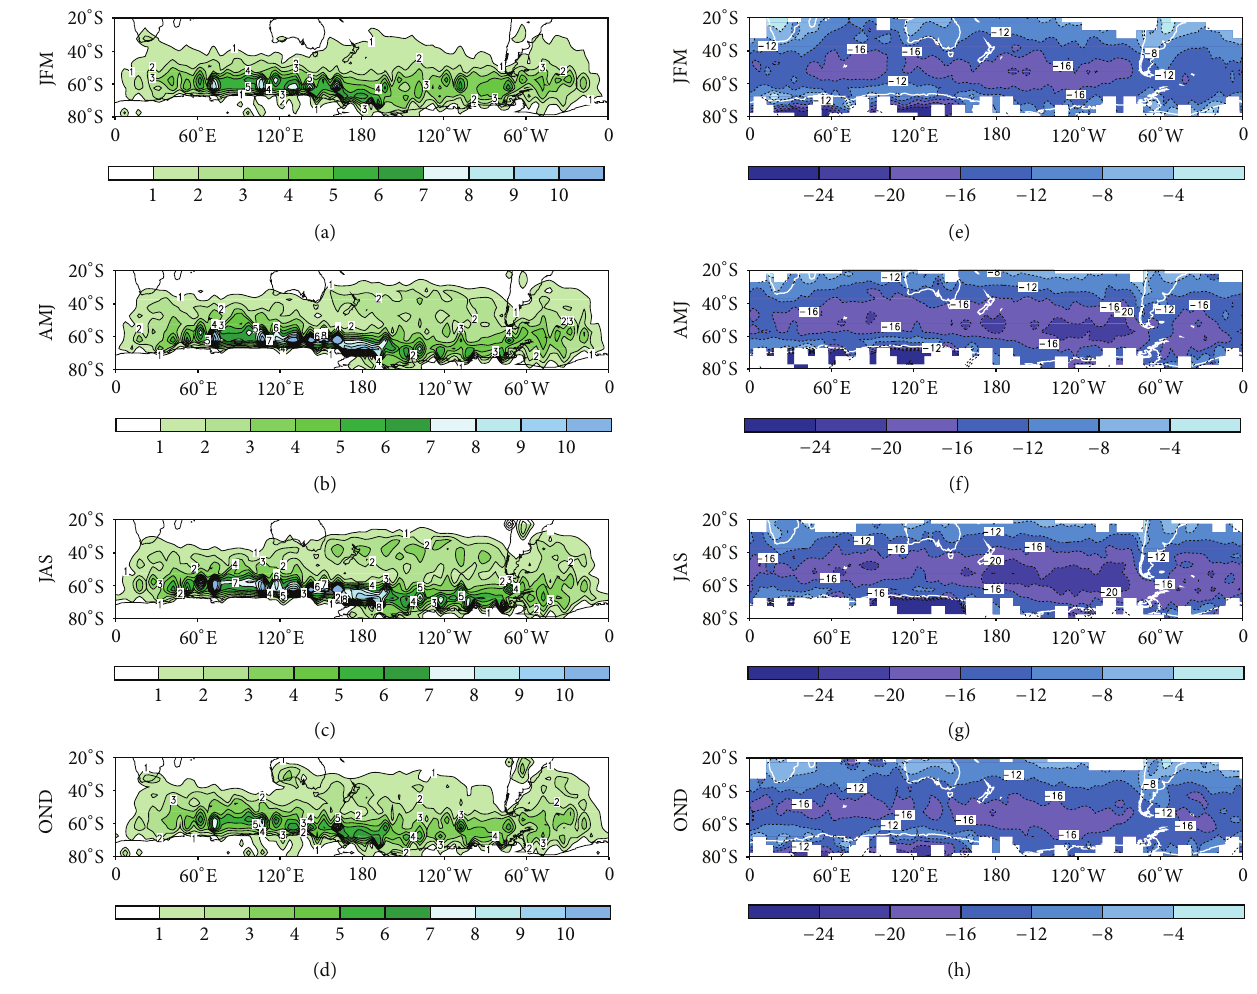
Figure 2: Southern Hemisphere seasonal cyclone track frequency climatology for NCEP1 5010 for (a) JFM, (b) AMJ, (c) JAS, (d) OND Units: seasonally averaged mean number of storms per 5 ∘ Lat/5 ∘ Lon grid box. Southern Hemisphere seasonal cyclone track intensity climatology per 5 ∘ Lat/5 ∘ Lon grid box for NCEP1 5010 for (e) JFM, (f) AMJ, (g) JAS, and (h) OND. Intensity calculated relative to seasonal mean sea-level pressure climatology for a unit: